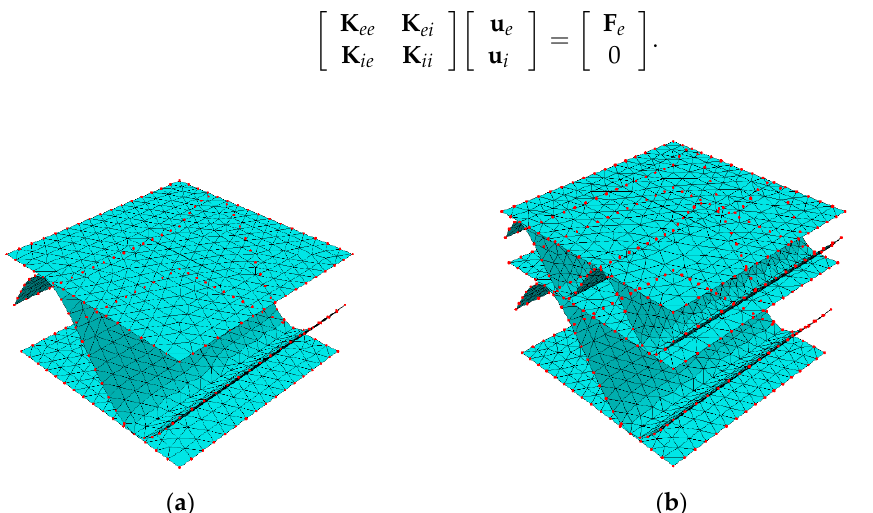
( j ) Figure 9. Cross section of the corrugated board along the wave: ( a ) the reference SW sample—no offset; ( b ) SW sample— offset equal to 1/16 P; ( c ) SW sample—offset equal to 2/16 P; ( d ) SW sample—offset equal to 3/16 P; ( e ) SW sample—offset equal to 4/16 P; ( f ) the reference DW sample—no offset; ( g ) DW sample—offset equal to 1/16 P; ( h ) DW sample—offset equal to 2/16 P; ( i ) DW sample—offset equal to 3/16 P; ( j ) DW sample—offset equal to 4/16 P. 2.3. Homogenization Technique In order to determine the effect of cuts on the stiffness of the corrugated board, the numerical homogenization method was used here. This method, originally proposed by